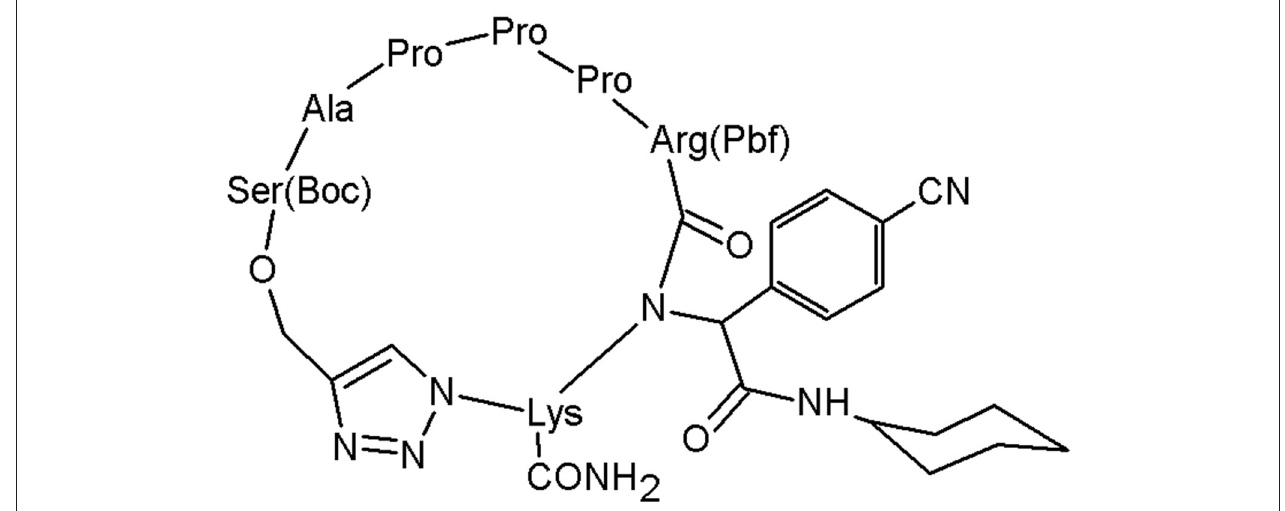
FIGURE 7 | The peptidomimetic active against lung cancer cells, including a triazole moiety (Tahoori et al.,